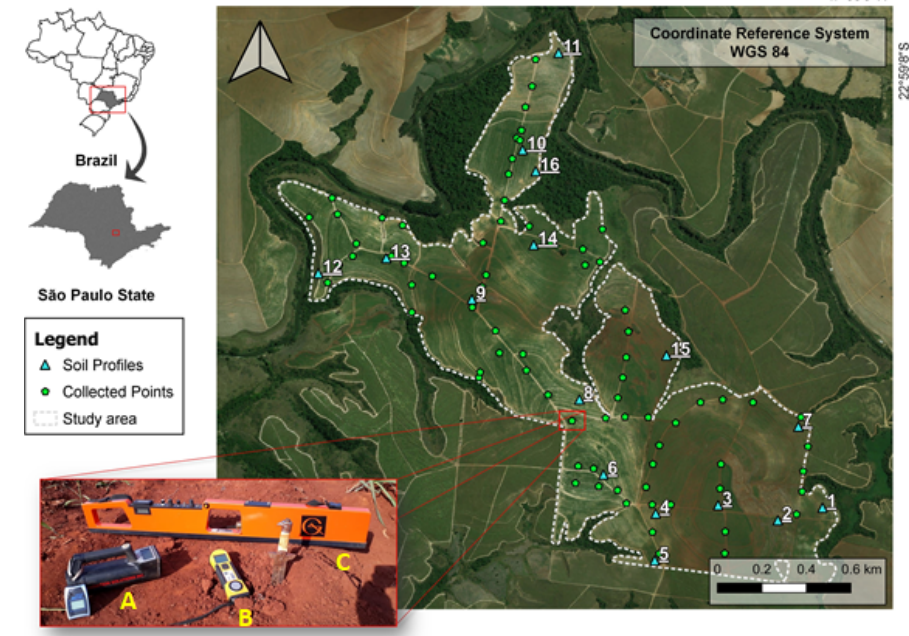
Figure 1. Study area, collection points, and geophysical sensors. A: gamma-ray spectrometer (Radiation Solution, RS 230); B: susceptibilimeter (KT-10 Terraplus); C: Geonics Ground Conductivity Meter (EM